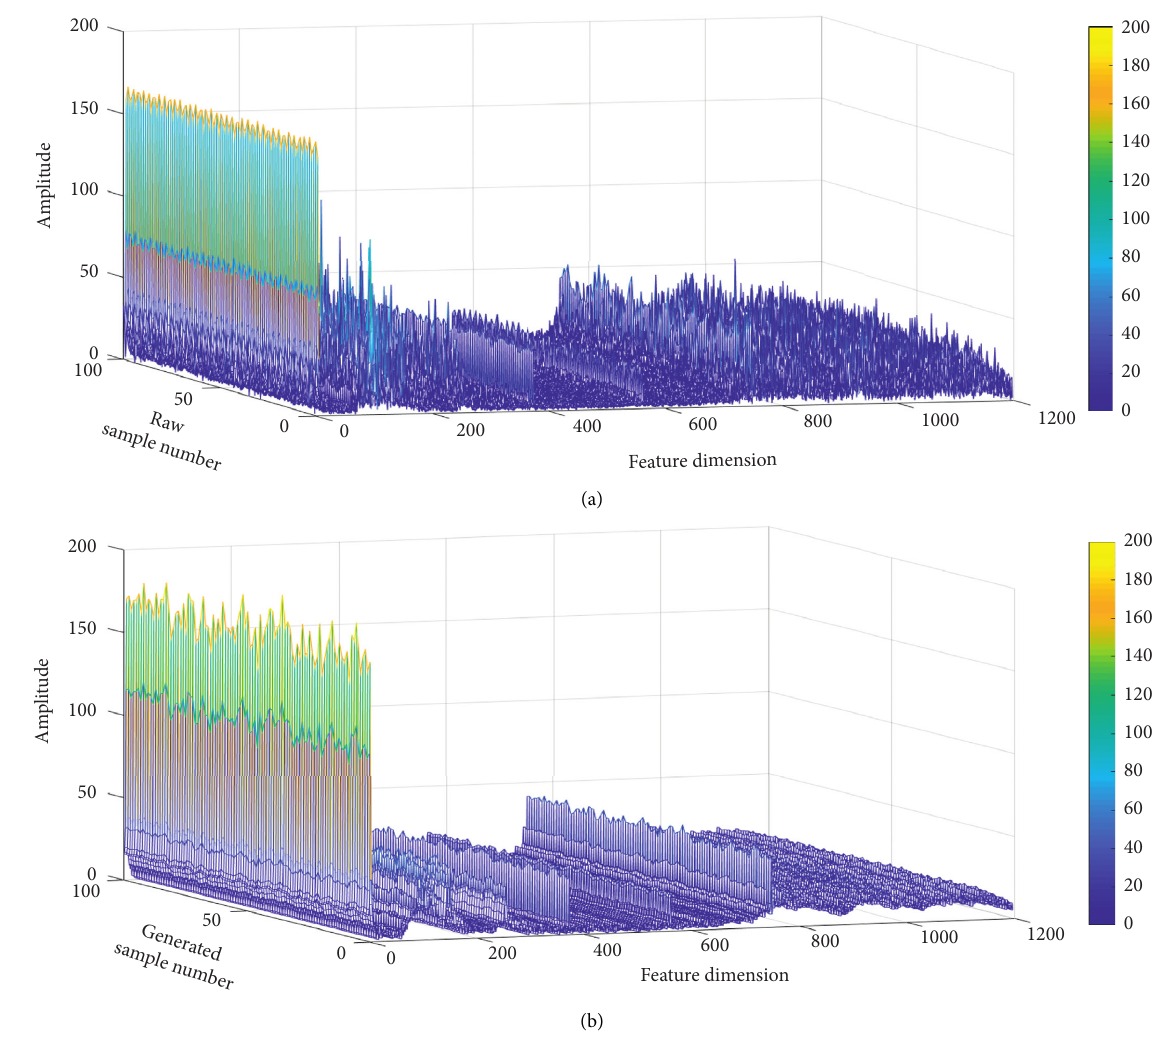
Figure 10: Comparison between the real sample and the generated sample of OF3.